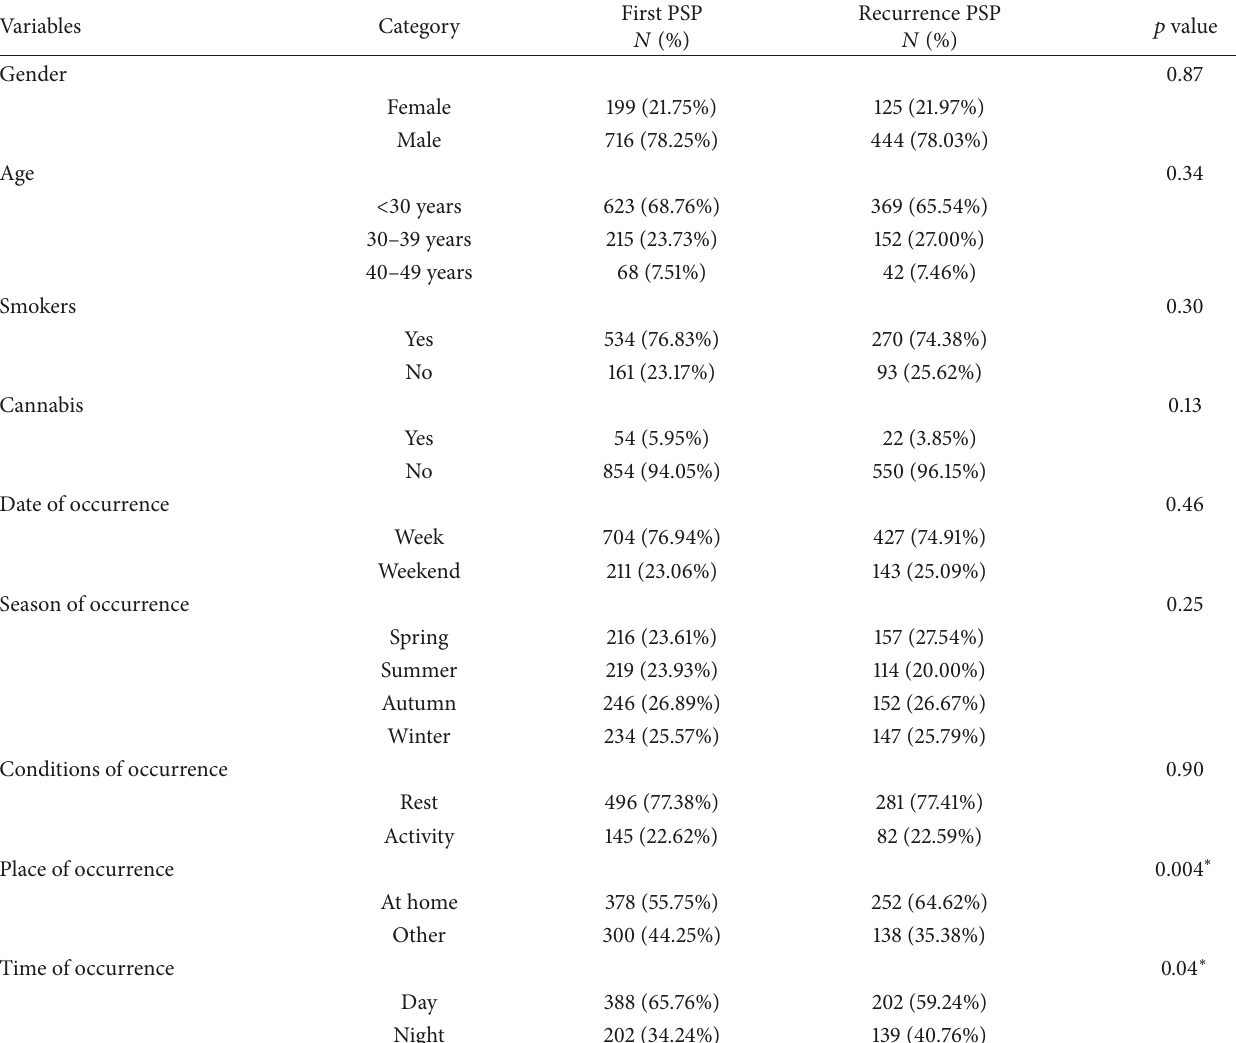
Table 1: Patients characteristics and conditions of occurrence in first PSP and recurrence